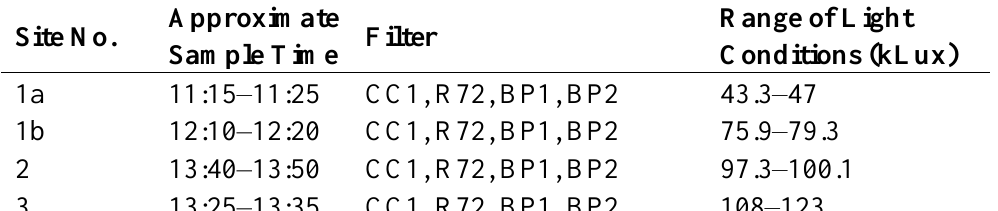
Table 3. Time and light conditions during acquisition of image bands at each site. Site No.